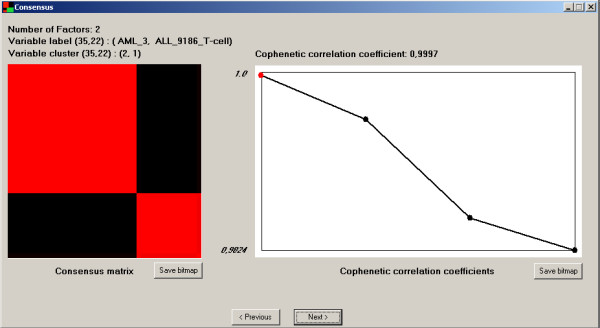
Graphical User Interface for the sample classification module. This panel shows the reordered consensus matrix and cophenetic correlation coefficient computed for each rank (k) used in the analysis. The figure shows the reordered consensus matrix obtained from 50 independent runs of NMF at k = 2 for the leukemia data used by Brunet et al. Graph on the right side represents cophenetic correlation coefficients obtained for k = 2-5.